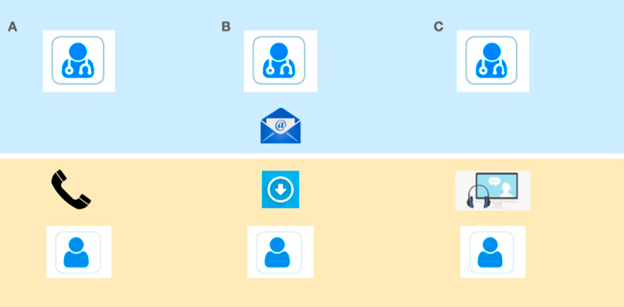
Figure 1. Enrollment scheme. ( A ) telephone contact and inclusion of the subject in the program. ( B ) e-mail with link to download the app and activation PIN. ( C ) Televisit and/or technical test .